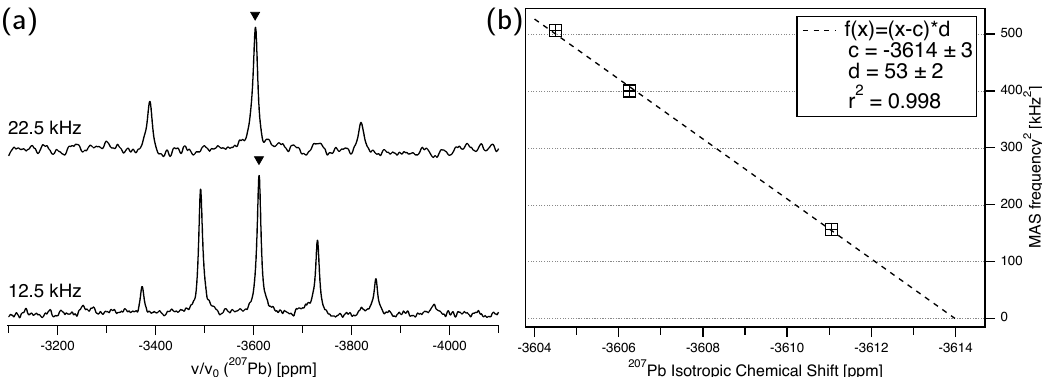
Figure 4. Left: 207 Pb magic-angle spinning NMR spectrum of polycrystalline anglesite, acquired in a Figure 5. ( a ) 207 Pb magic-angle spinning NMR spectra of polycrystalline anglesite, acquired at the magnetic field of ~ B 0 =11.7T at 22.5kHz spinning speed, with the isotropic band indicated at -3604.5ppm. indicated MAS frequencies, with isotropic bands marked by a triangle. ( b ) Plot of the 207 Pb isotropic Right: 207 Pb isotropic chemical shift of anglesite at various MAS spinning speeds versus the corresponding chemical shift of anglesite versus the squared MAS frequency, with the linear fit given by the dashed spinning speed, with the least-square fit (dashed line) showing good linear correlation. An extrapolation line. An extrapolation to zero spinning speed results in an isotropic chemical shift of 3614 3 − ± to zero spinning reveals an isotropic chemical shift of -3619 4ppm, which is in good agreement with the ± single-crystal experiments.